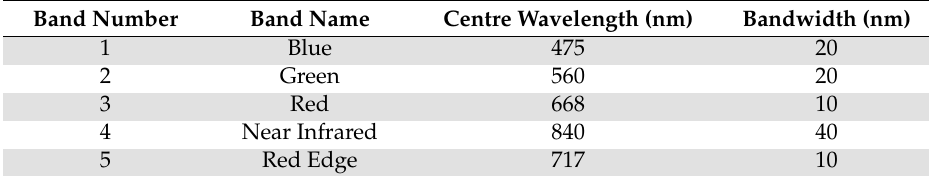
Table 1. Features of the spectral bands captured by the multispectral camera MicaSense RedEdge-M TM .